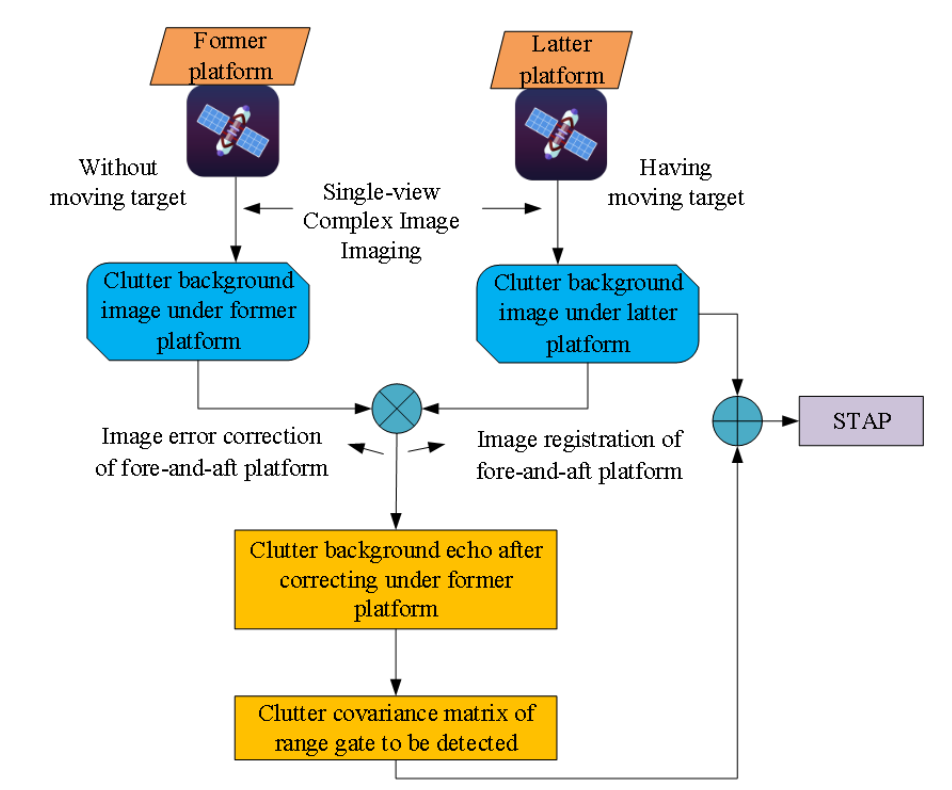
Figure 6. The simplified flowchart of the proposed GMTI